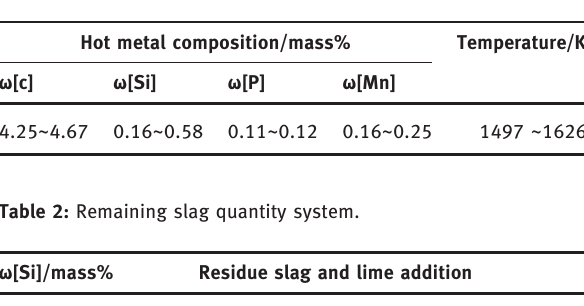
Table 1: Raw material condition of industrial trial with a 150 metric ton BOF.